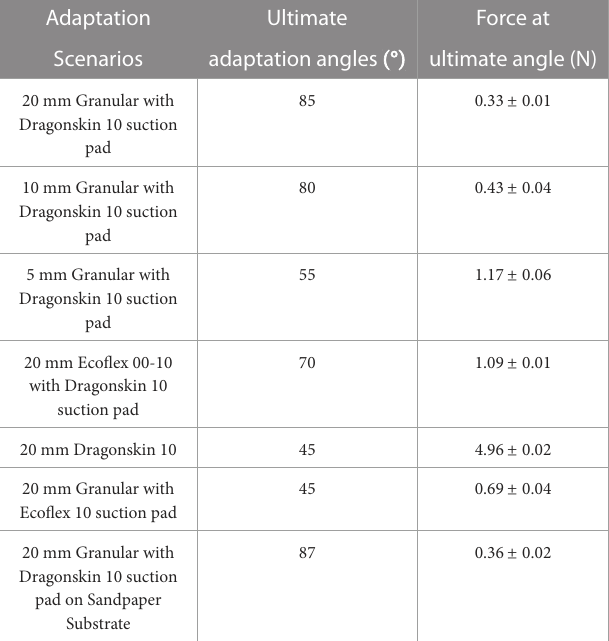
TABLE2 Ultimateadaptationangleandtherequiredforceforadaptationat theseanglesforvariousscenarios.